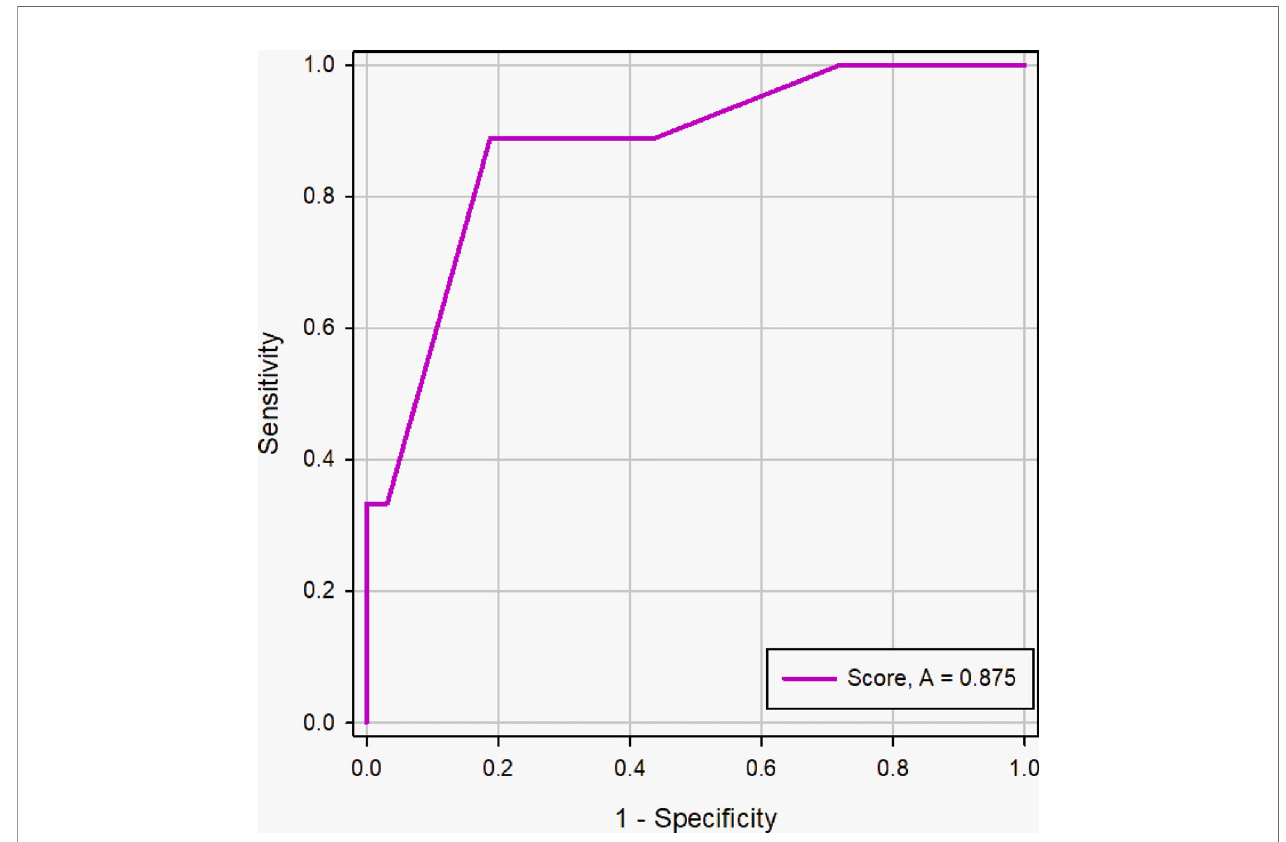
FIGURE 9 | ROC curve of the scoring system in the nodule size <2cm group. The AUC was 0.875 (95% CI: 0.734 - 0.957, p <